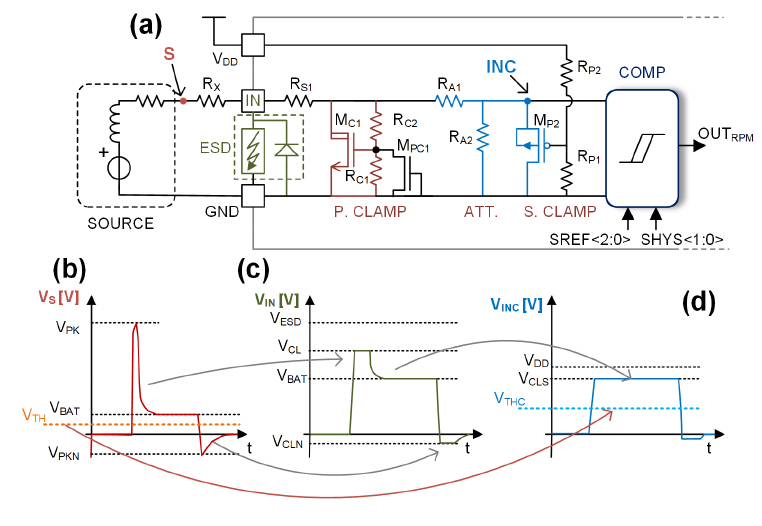
Figure 4. ( a ): Sensing circuit for automotive signals with concurred ESD, over and under voltage protection [32]. ( b ): Signal at node S . ( c ): Corresponding signal at the input pad. ( d ): Signal at the comparator input.